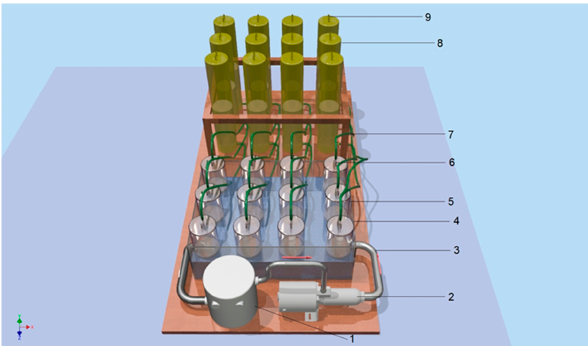
Figure 1. The anaerobic bioreactor (12-chamber section) used in the biogas production experiment: 1—water heater; 2—water pump; 3—insulated tubes for heating medium; 4—water jacket (39 °C); 5—bioreactor (1.4 L); 6—slurry sampling valve; 7—tube for biogas transport; 8—graduated tank for biogas; 9—gas sampling valve